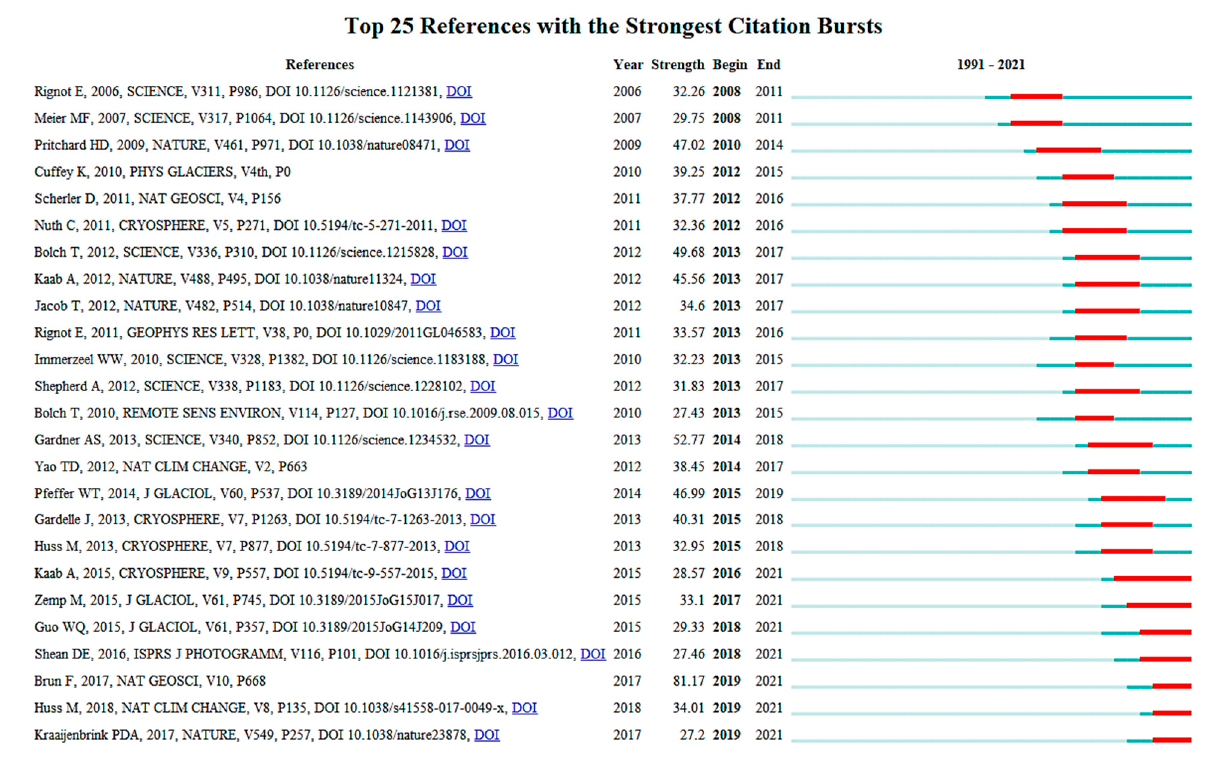
Figure 9. The top 25 references with the strongest citation bursts [3,6,19,24,49,60–64,66–80].